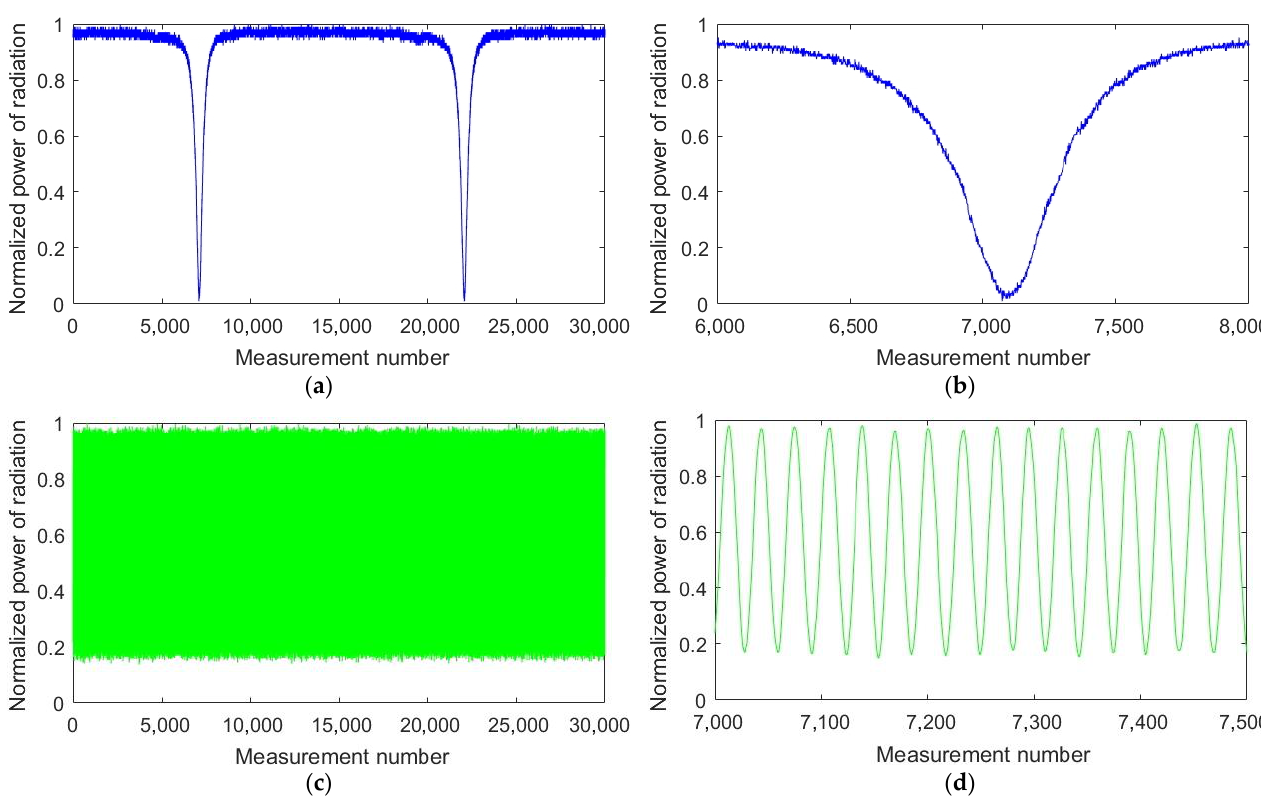
Figure 4. Normalized signal from a photodetector, 4, ( a ) and the same with a better resolution ( b ), signal from a photodetector, 10, ( c ) and the same with a better resolution ( d ).